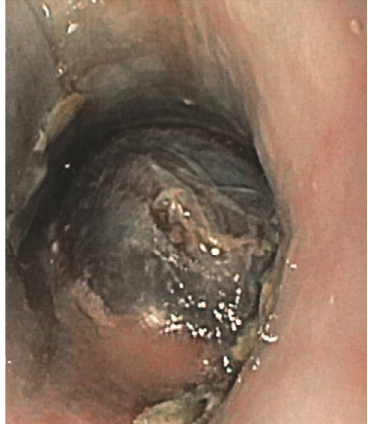
Figure 1: Endoscopic view of a bluish mass obliterating the lumen of the proximal esophagus.